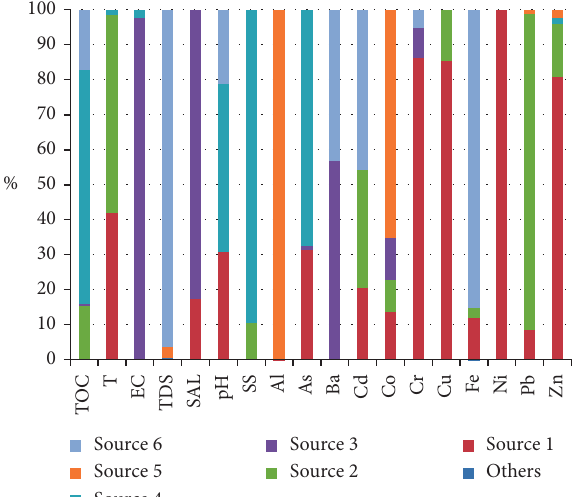
Figure 4: Concentration % for water quality parameters in